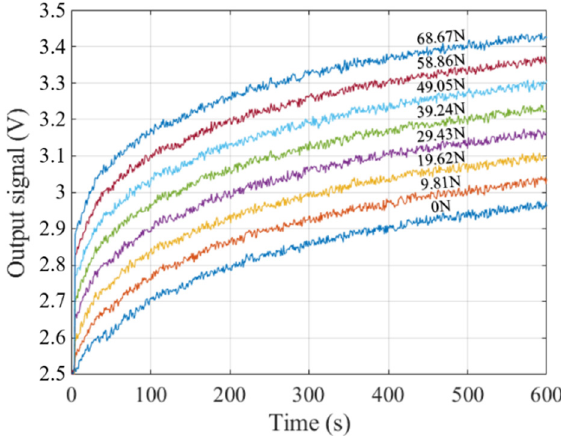
Figure 10. The output signal of the film force sensor under variety cutting force magnitudes.